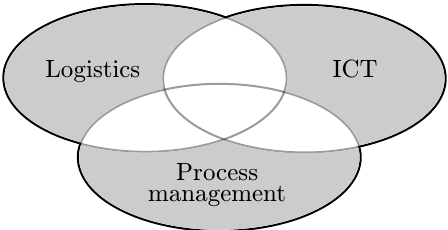
Figure 7: E-logistics, interaction and alignment between logistics, ICT and process management (Ericsson